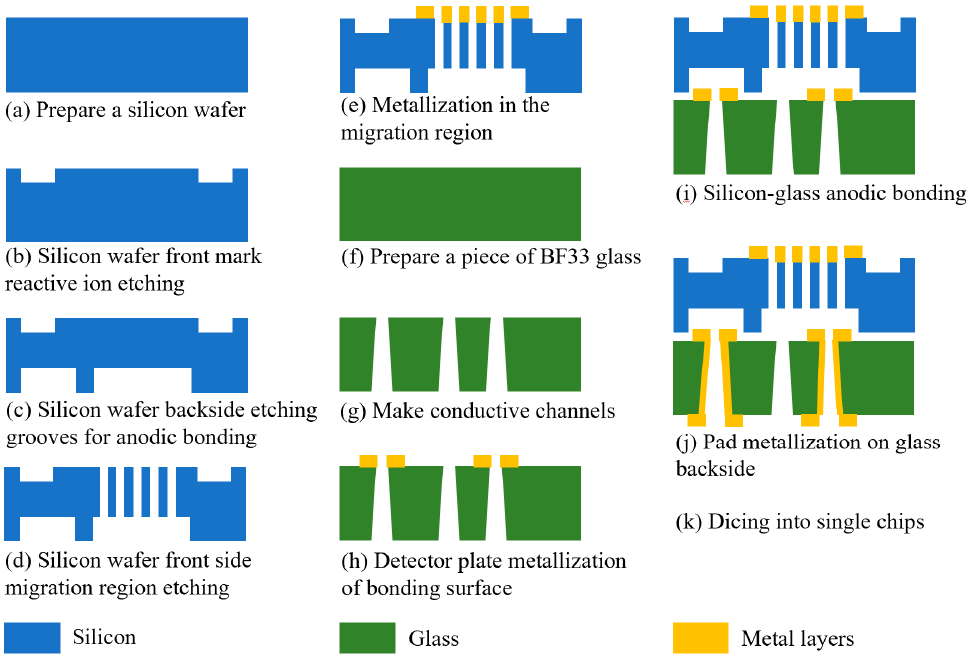
Figure 6. Schematic diagram of each process step in sensor chip fabrication.